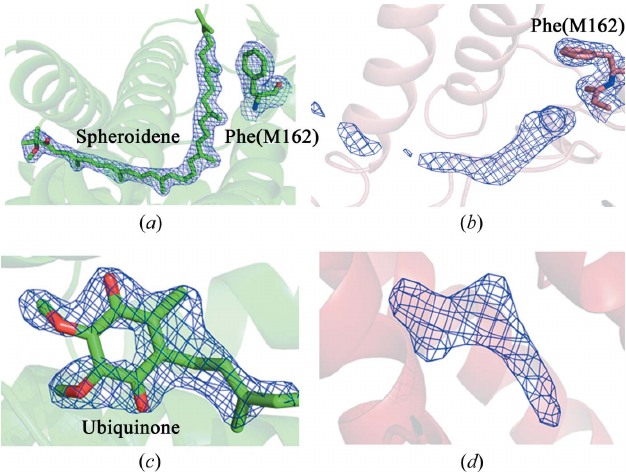
Figure 3 Fragment of the electron density map of the Rba. sphaeroides RC structure. ( a ) In the carotenoid binding site, under in surfo conditions, at 2.1 A˚ resolution, 1.6 (cid:2) ; ( b ) in the carotenoid binding site, in the LSP, at 2.1 A˚ resolution, 1.0 (cid:2) ; ( c ) in the Q B binding site, under in surfo conditions, at 2.1 A˚ resolution, 1.6 (cid:2) ; ( d ) in the Q B binding site, in the LSP, at 2.1 A˚ resolution, 1.0 (cid:2) .